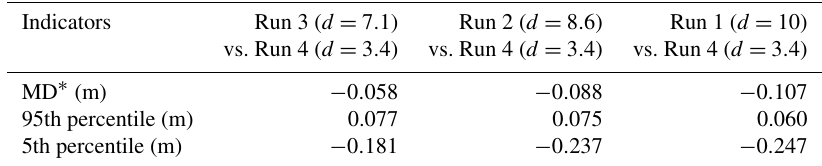
Table 4. Differences between upscaled water depths derived from various runs of Araud (2012).